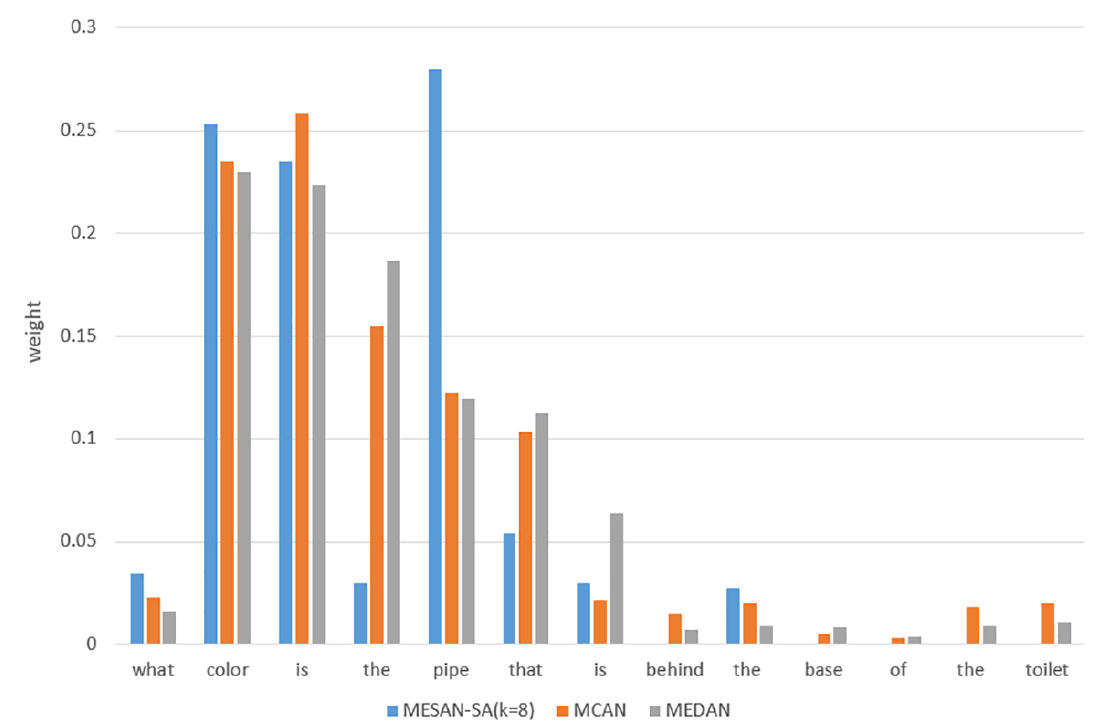
Figure 6. The visualization results of the attention of MESAN-SA( k = 8), MCAN, and MEDAN for a specific question. The ordinate is the weight to measure the importance of a